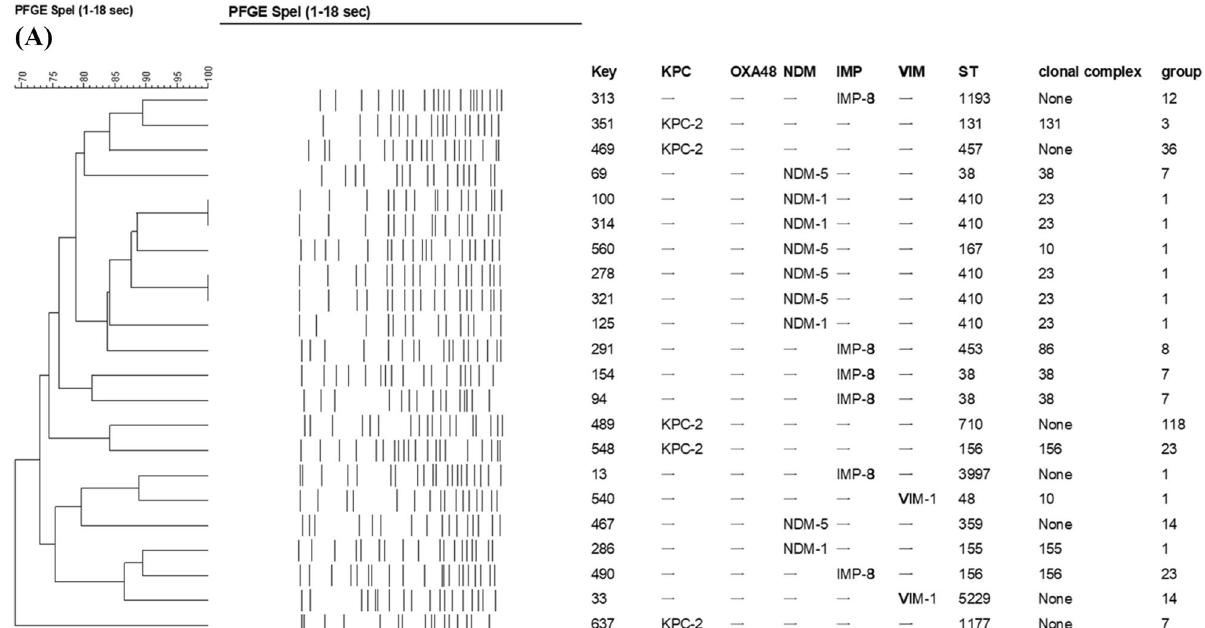
Figure 2. Comparisons of carbapenemase-producing ( A ) E. coli and ( B ) K. pneumoniae isolates by PFGE dendrogram and